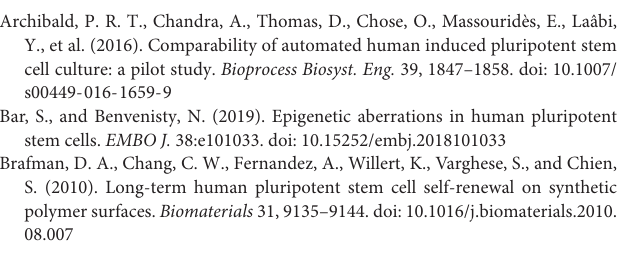
Supplementary Figure 1 | Comparison between automated and manual plating of human fibroblasts. Assessment of successfully plated cells after automated vs. manual seeding of 80,000 HF into wells of a 24-well plate (mean ± SD; n = 9). Plated cells were directly recovered after distribution and counted. CV = Coefficient of variation (%); SCF = StemCellFactory.